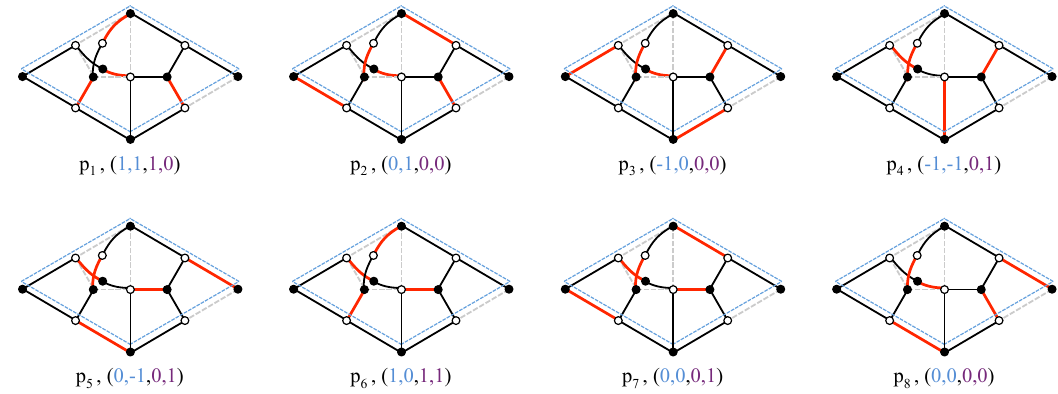
Figure 29. Surviving perfect matchings. The new coordinates are determined by the edge content on the bridges, using the convention in (cid:12)gure 27.